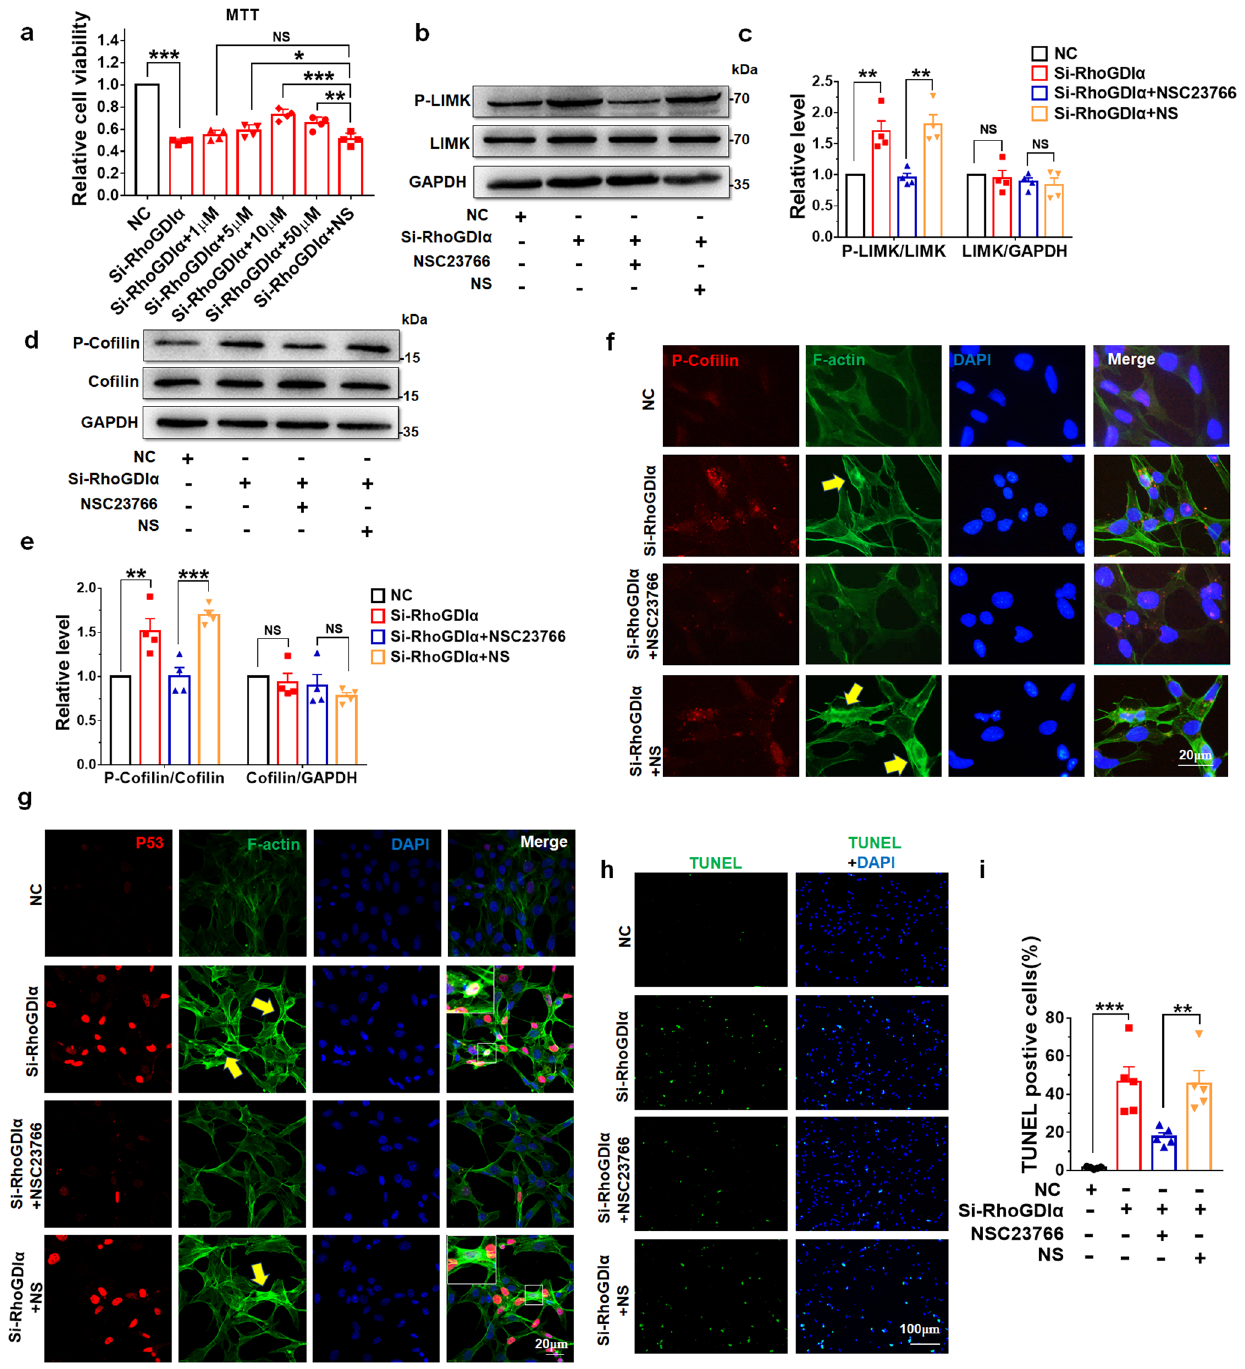
Fig. 7 NSC23766 mitigated the effects of RhoGDI α knockdown on GC1-spg cells. a Optimum concentration of NSC23766 to improve cell viability was evaluated by MTT assay. 1 μ M, 5 μ M, 10 μ M, and 50 μ M represent the concentration of NSC23766, and NS represents normal saline. b , c GC-1spg cells were treated with 10 μ M NSC23766 for 48 h after transfection with Si-RhoGDI α , and then P-LIMK and LIMK levels were tested. d , e Co fi lin and its phosphorylation level were tested after NSC23766 treatment. a , c, and e n = 4 batches of cells in each group. f Immuno fl uorescence results of P-co fi lin and F-actin co-staining in GC-1spg cells. Scale bar = 20 μ m. g Immuno fl uorescence staining of P53 and F-actin in GC1-spg cell transfection with Si-RhoGDI α and then treatment with NSC23766. Scale bar = 20 μ m. The images in the white solid wire box are magni fi ed images of the corresponding white-dotted box. The yellow arrow indicates abnormal aggregation of F-actin. h , i TUNEL assay was used to test GC1-spg cell apoptosis. Scale bar = 100 μ m. n = 5 batches of cells in each group. * P < 0.05, ** P < 0.01, *** P < 0.001, NS non-signi fi cant. Data are presented as the mean ± standard error.